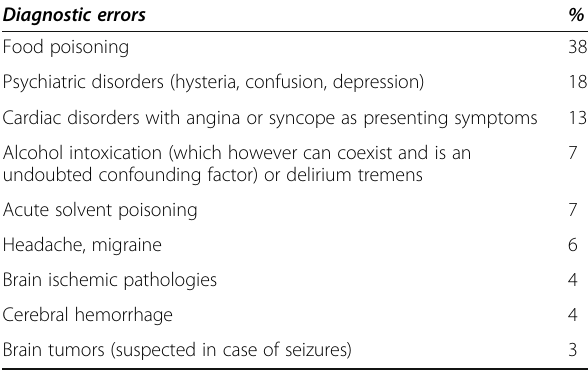
Table 3 Common diagnostic errors in carbon monoxide poisoning